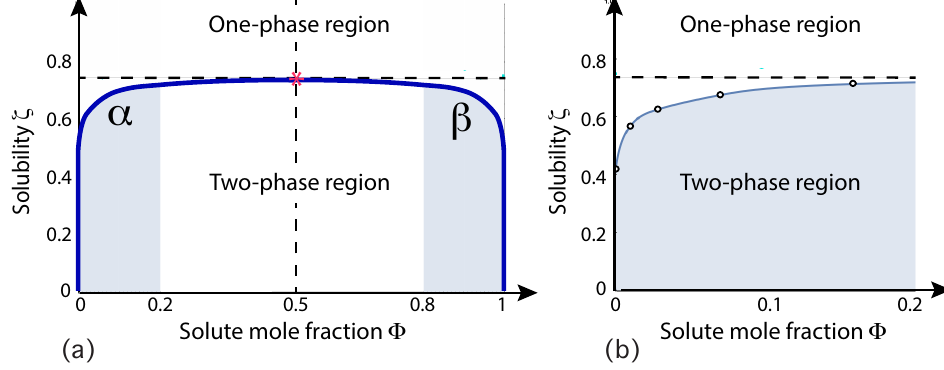
Figure 6. Phase diagram for a binary mixture of water and solute molecules as a function of solute mole fraction Φ S and solubility ζ of the solute molecules in water [50]: ( a ) Global phase diagram for 0 ≤ Φ S ≤ 1. The phase diagram is mirror symmetric with respect to the dashed vertical line at Φ = 1/2, which implies horizontal tie lines. The critical demixing point (red star) with coordinates S ( Φ ) = ( 1/2,0.746 ) is located at the crossing point of the dashed vertical line and the binodal line S , ζ (dark blue), and ( b ) Phase diagram for 0 ≤ Φ S ≤ 0.2 corresponding to the grey-shaded region on the left of panel a. The four data points (open circles) on the binodal line have been determined by molecular dynamics simulations [50]. The binary mixture forms a uniform phase above the binodal line and undergoes phase separation into a water-rich phase α with Φ S < 0.5 and a solute-rich phase β with Φ S > 0.5. Essentially the same phase diagram is obtained when the solubility is replaced by the